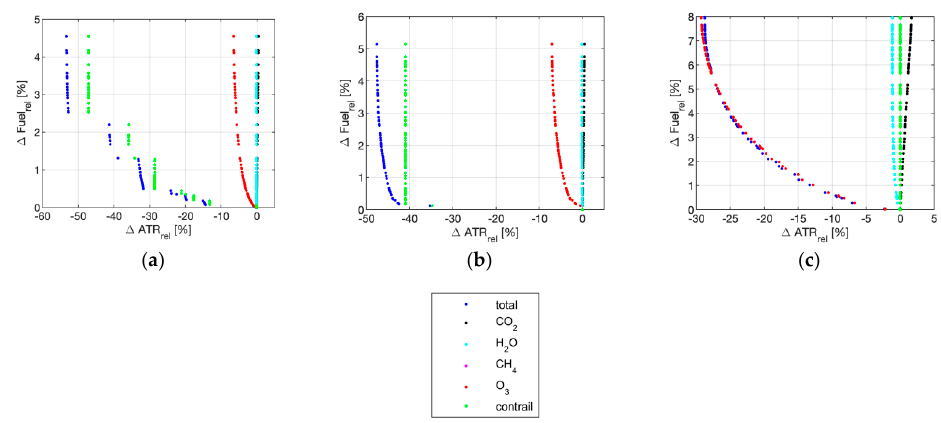
Figure 2. Pareto fronts for aircraft trajectory optimization showing average temperature response (ATR 20 ) vs. fuel increase for Lulea–Gran Canaria ( a ), Helsinki–Gran Canaria ( b ), Baku–Luxembourg ( c ) and individual effects. For given fuel increase, dark blue dots show the optimal climate change impact from the possible routes available. Other individual dot colours indicate the CO 2 and non-CO 2 climate impacts for that alternative route.